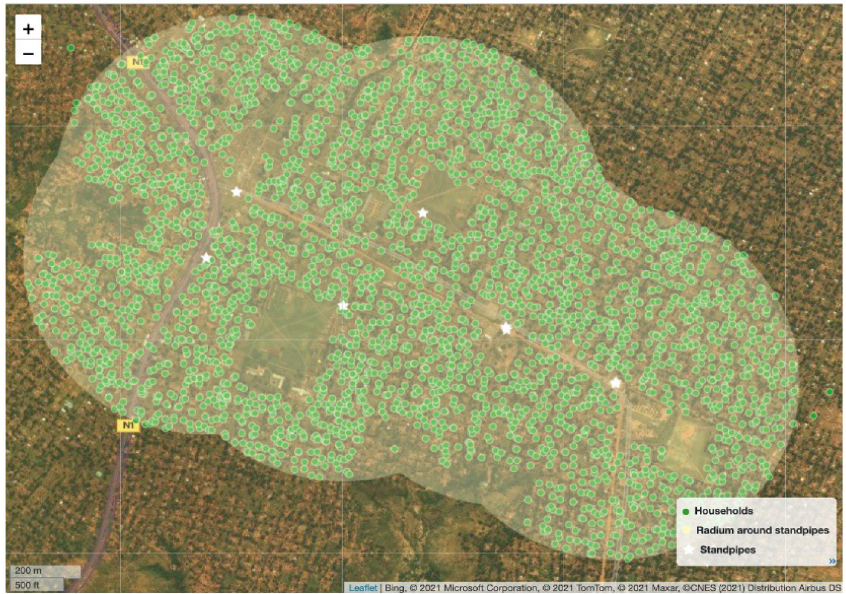
Fig 3. Household surveying near ACAEL water service provider. Households surveyed during census within 500 meters of ACAEL water service provider standpipes in Kasai Oriental Province.